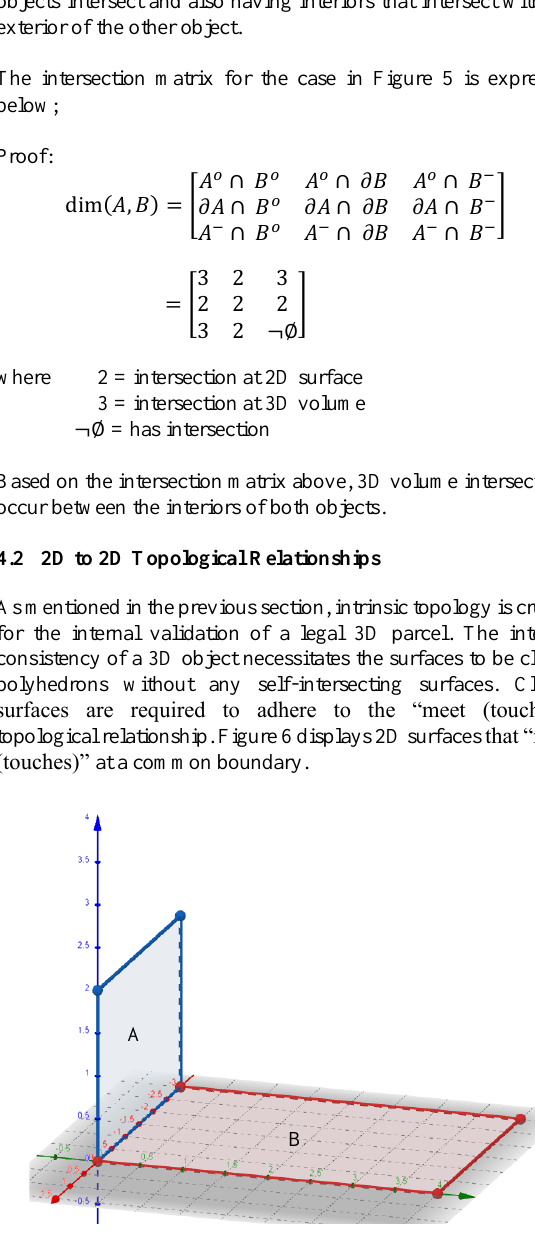
Figure 6 . 2D to 2D “meet (touches)” topological relationship with a common boundary. The 2D to 2D “meet (touches)” topological relationship which intersects at a common boundary can be defined as follows; Condition: 2D surfaces “meet (touches)” when the interior surfaces do not intersect. The 2D surfaces must also have a common boundary at either 1D line or 0D vertices.